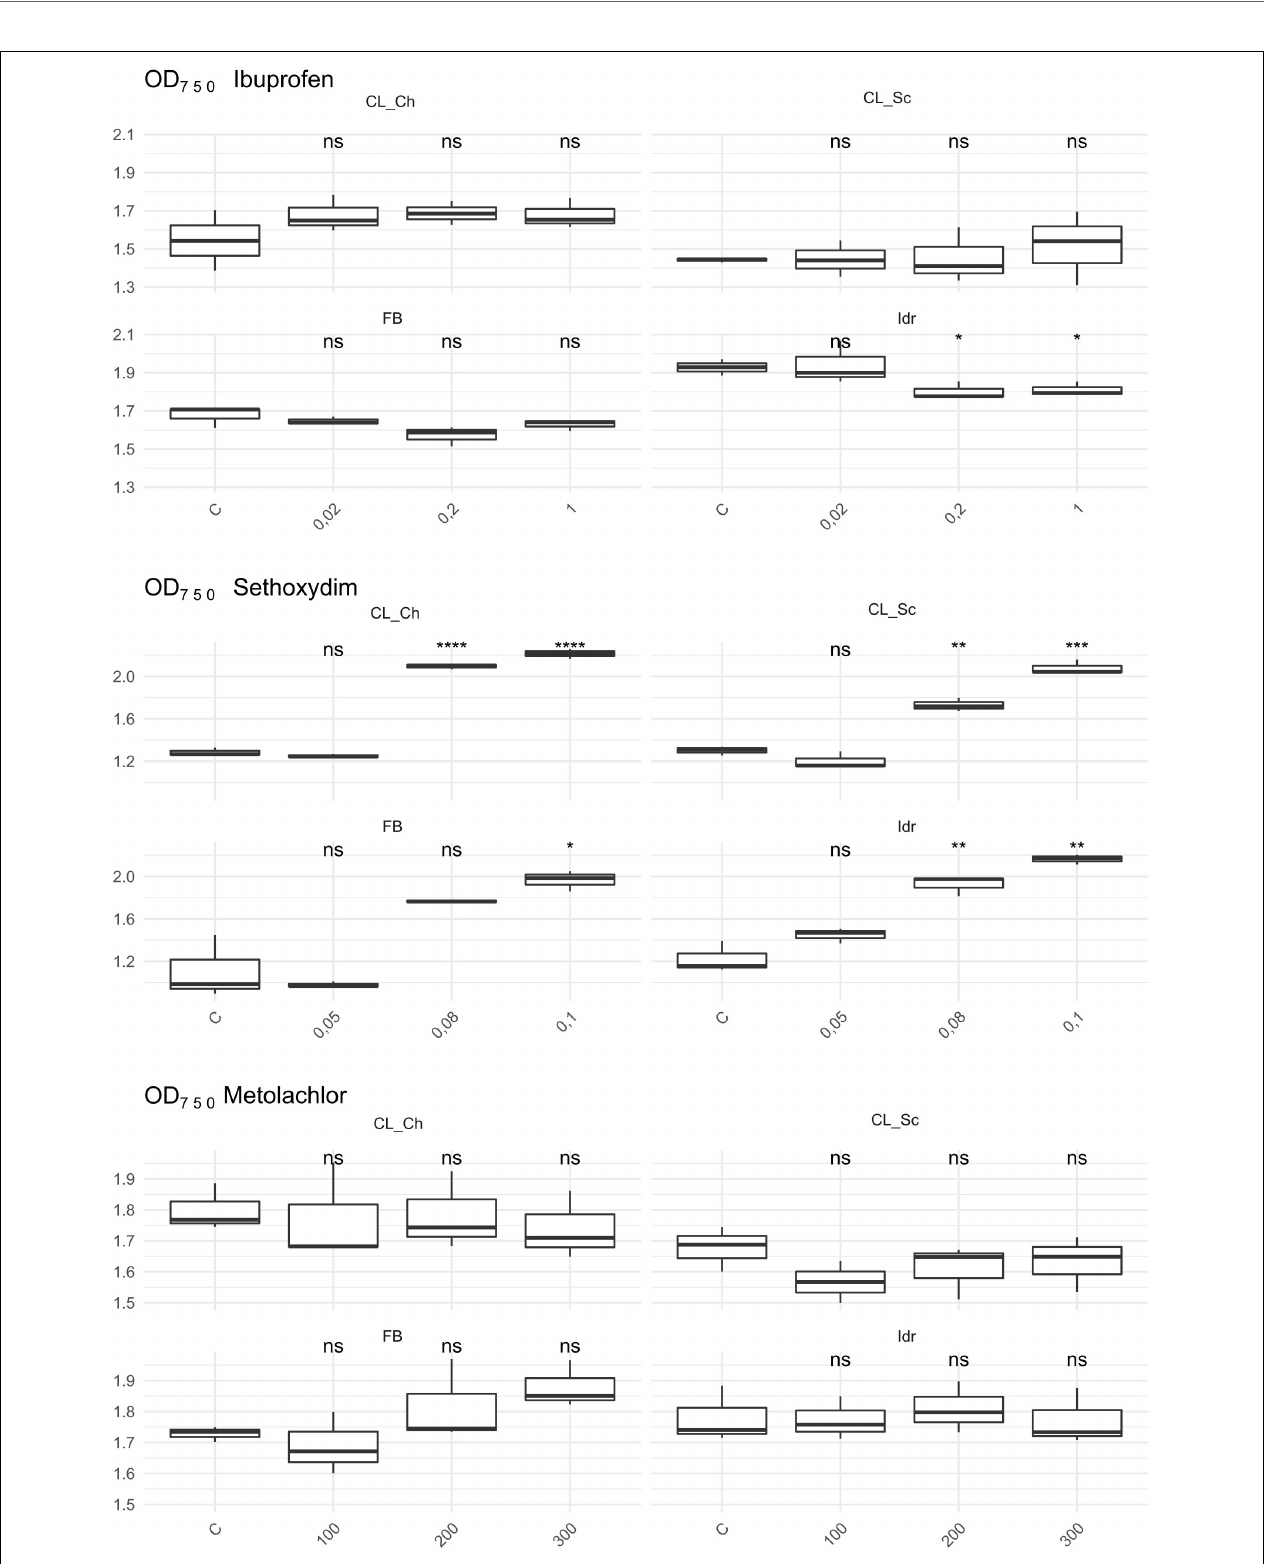
FIGURE 6 | OD 750 value measured after 1 week exposure at herbicides and Ibuprofen. T -test has been applied to compare the effect of the presence of the substances with the control (C). The following convention for symbols indicating statistical significance were used: ns: p > 0.05; *: p ≤ 0.05; **: p ≤ 0.01; ***: p ≤ 0.001; ****: p ≤